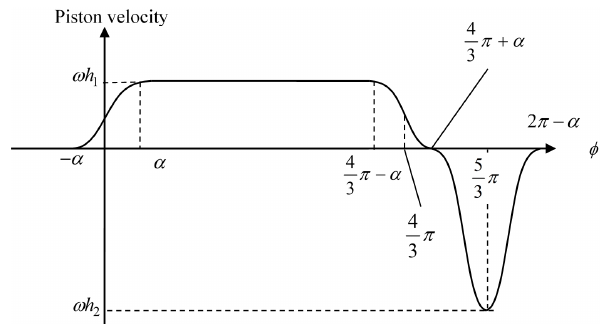
Figure 8. Piston velocity of the three-piston pump using cam